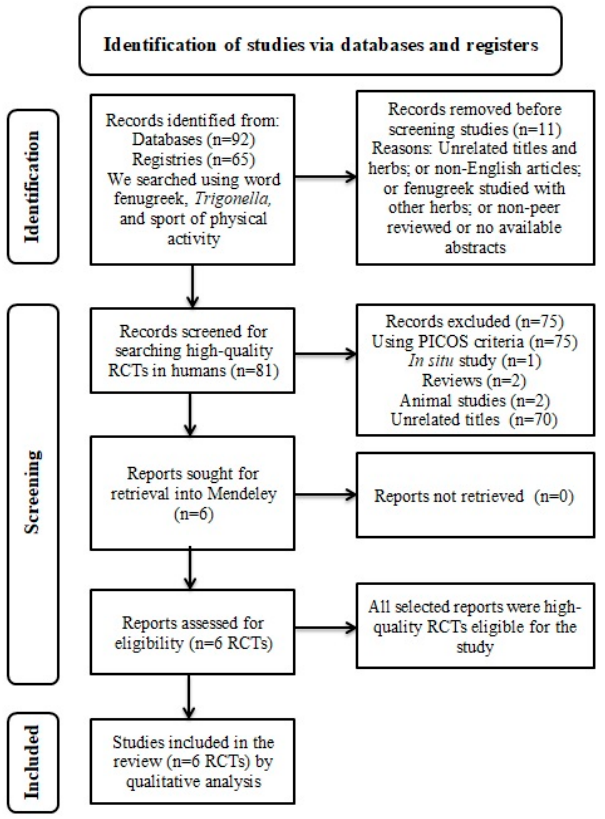
Figure 3. PRISMA flow diagram.